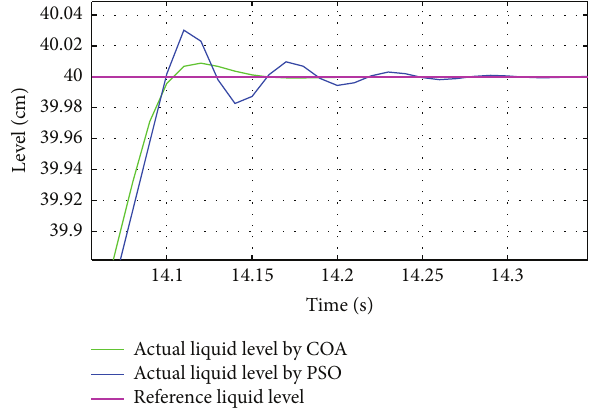
Figure 10: Response of fuzzy controller tuned using COA and PSO (level set: 40cm at 𝑡 = 10